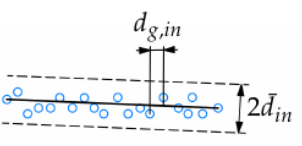
Figure 5. Inliers for a line segment with the inlier tolerance ¯ d in . The gap between points along the x 0 axis is denoted d g , in